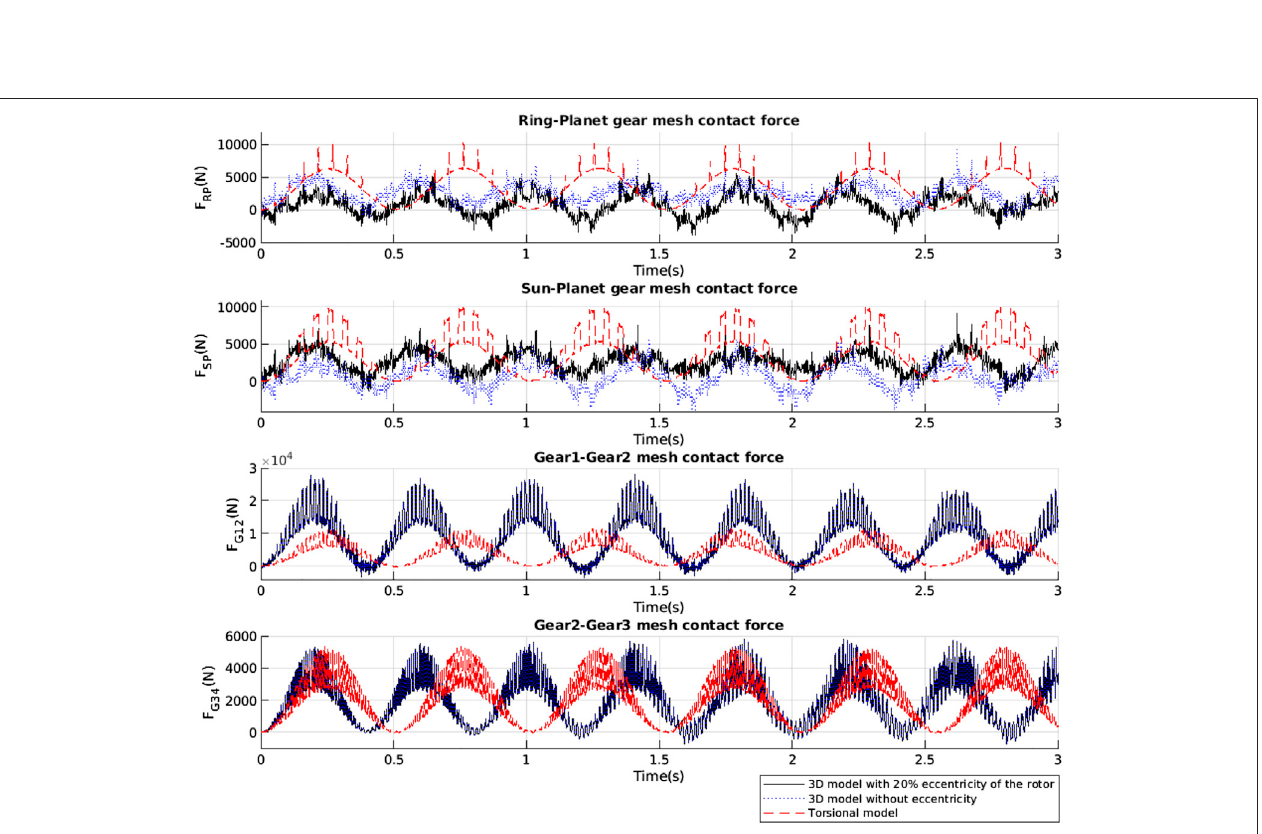
FIGURE 11 | Eccentricity influence on the gear mesh contact force of each component.